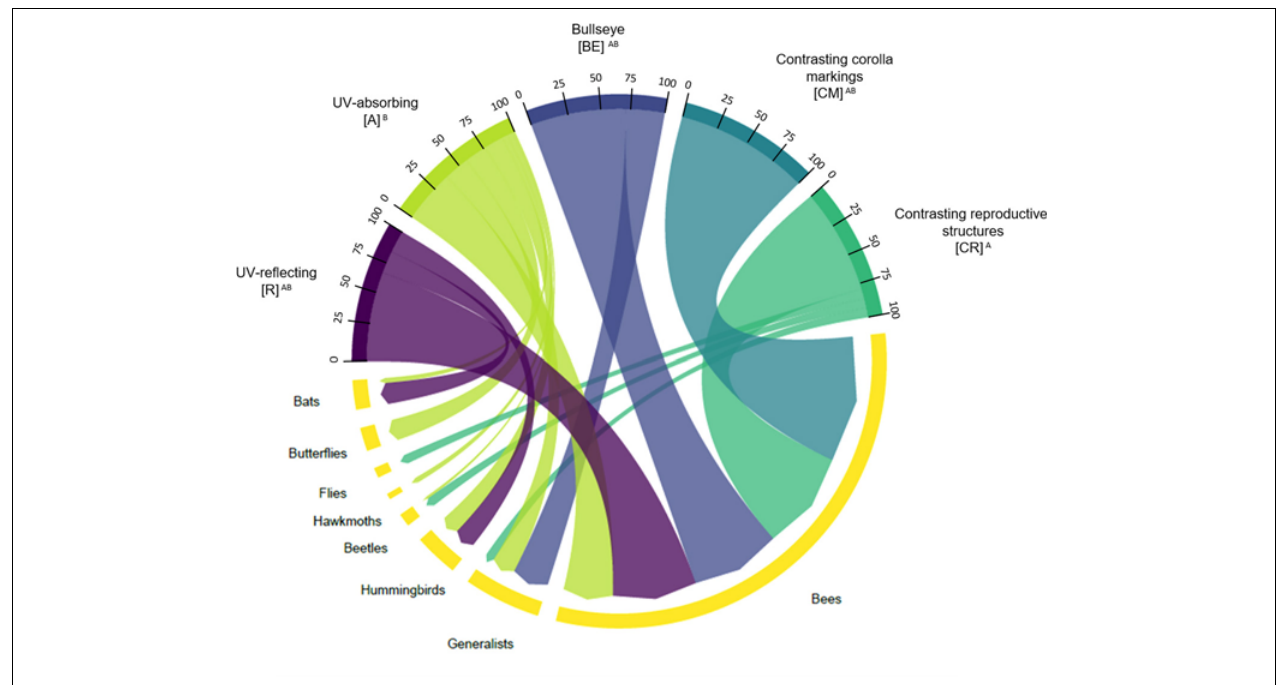
FIGURE 8 | Chord diagram showing the relationship between the types of floral UV features and pollination systems of 80 plant species. The chords are unidirectional. Chord thickness corresponds to the percentage of species with each floral UV feature that is related to a given pollination system. Similar letters indicate that the UV categories were related to similar proportions of each pollination system ( χ 2 = 9.5294; p = 0.04915). See Supplementary Tables 3 , 4 for percentages and detailed statistics. R, non-patterned UV-reflecting; A, non-patterned UV-absorbing; BE, bullseye; CM, contrasting corolla markings oriented towards floral resources; CR, contrasting reproductive